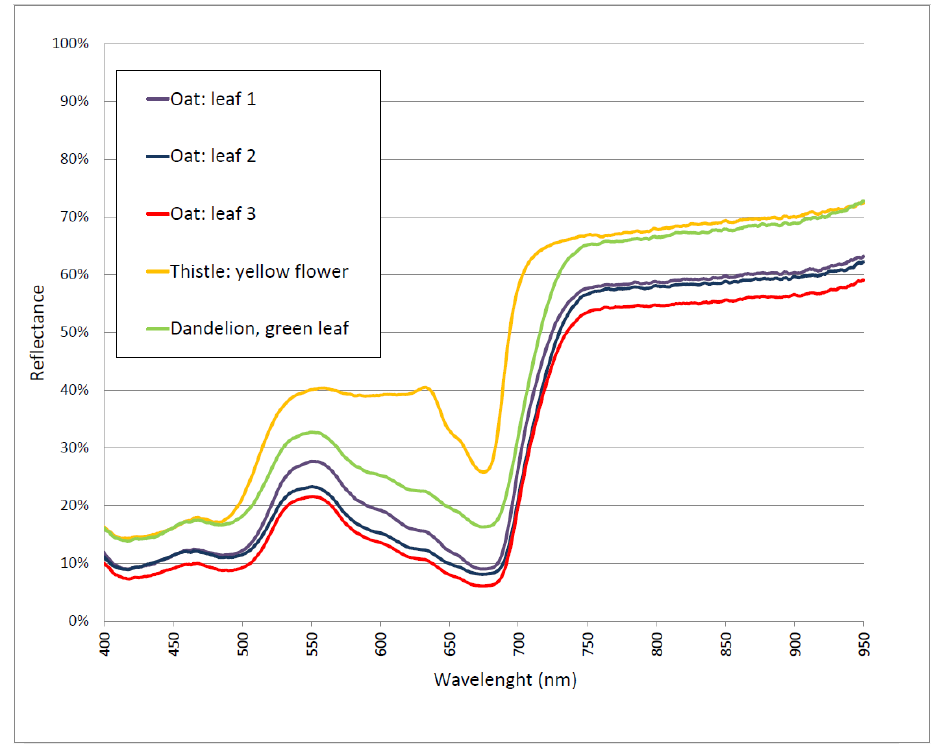
Figure 3. Reflectance signatures of different crops on 23 July 2019: different oat (Avena Sativa) leaves, yellow star thistle flower (Centaurea Solstitalis) weed, and dandelion ( Taraxacum Officinale) weed in our unpublished study. The presented signatures were raw data measured with a CI-710 leaf spectrometer (CID Bio-Science, Camas, WA,